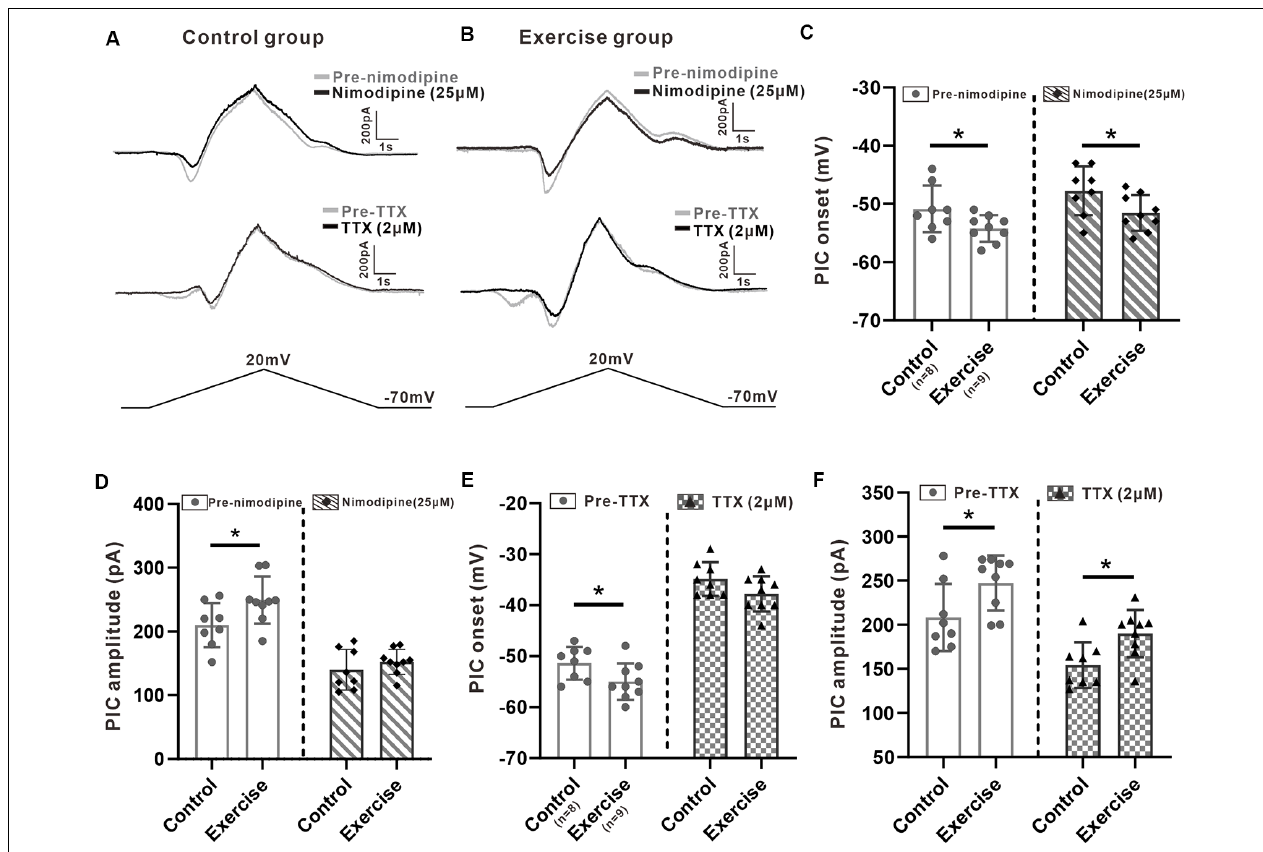
FIGURE 5 | Effects of treadmill exercise on each component of PICs. (A) Examples of the effects of nimodipine (25 µ M, top traces) and TTX (2 µ M, middle traces) on PICs in the control group. (B) Examples of the effects of nimodipine (25 µ M, top traces) and TTX (2 µ M, middle traces) on PICs in the exercise group. (C) Exercise training significantly hyperpolarized the onset of composite PIC (left panel, unpaired Student’s t -test, p = 0.049). Significant difference was also observed in Na-PIC onset between control and exercise groups with nimodipine (right panel, unpaired Student’s t -test, p = 0.049). (D) Exercise training significantly increased the composite PIC amplitude (left panel, unpaired Student’s t -test, p = 0.039). There was no significant difference in Na-PIC amplitude between the control and exercise groups (right panel, unpaired Student’s t -test, p = 0.345). (E) Exercise training significantly hyperpolarized the onset of composite PIC (left panel, unpaired Student’s t -test, composite p = 0.046). There was no significant difference in Ca-PIC onset between the control and exercise groups (right panel, unpaired Student’s t -test, p = 0.098). (F) Exercise training significantly increased the amplitude of composite PIC (left panel, unpaired Student’s t -test, p = 0.034). However, even reduced by TTX, the amplitude of Ca-PIC measured from the exercise group was still bigger than that from the control group (right panel, unpaired Student’s t -test, p = 0.013). * p < 0.05.